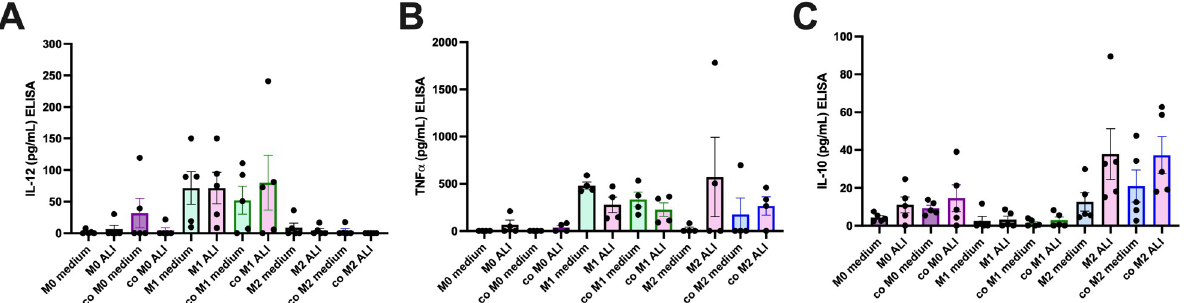
Fig 4. Assessment of phenotypic changes after co-culture of macrophages with HBECs by ELISA. Media was collected after 72 hours of co-culture of macrophages and HBECs and ELISAs for IL-12p70, IL-10, or TNF α were performed. For statistical analysis, ANOVA was performed within each group and compared to monoculture in the medium appropriate for each macrophage (n = 4–5) but no significant differences were found.